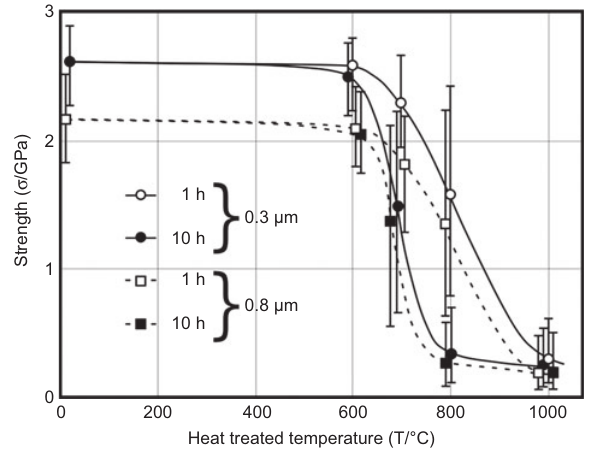
Figure 2 Scanning electron microscope photograph of pits on HS-fi ber after heat